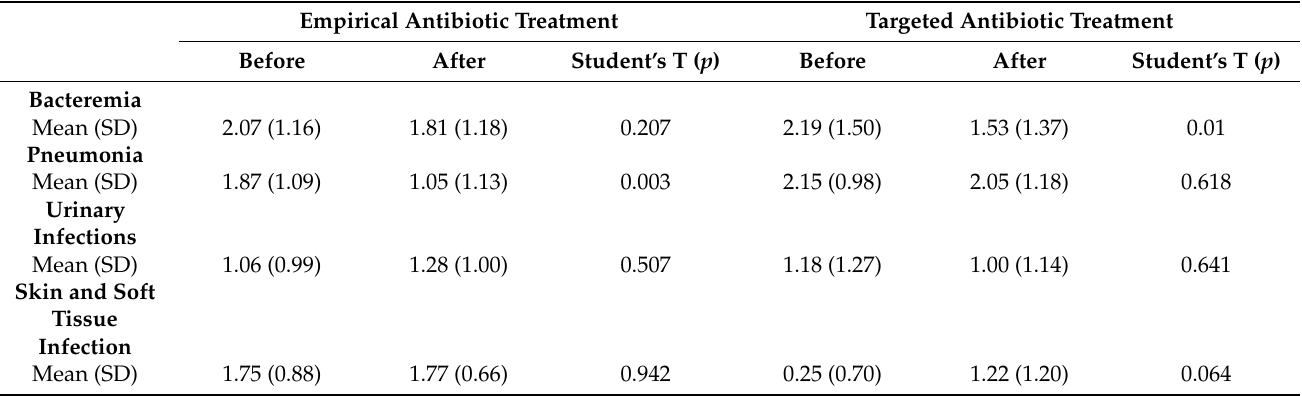
Table 4. Comparison of antibiotic consumption before and after training in empirical and targeted treatment of 257 patients of the internal medicine ward and intensive care unit of HEEE. Empirical Antibiotic